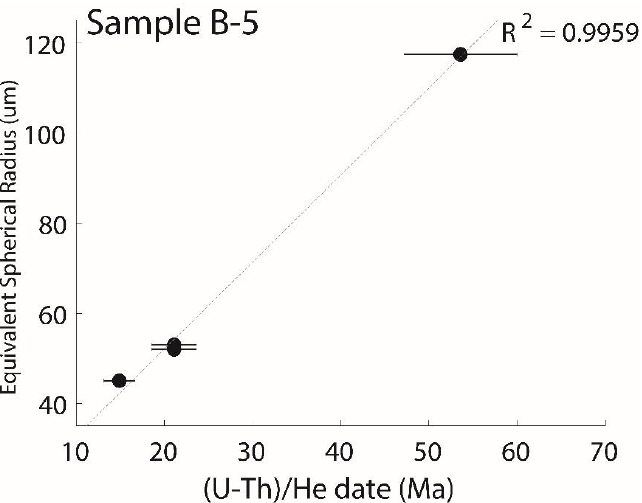
Figure 4. (U-Th) / He date for sample B − 5 plotted vs. grain size [12]. The biggest grain with the largest measured date was rejected based on a Q-test, even though the variation is legitimate because the closure temperature of the large grain is hotter than the smaller grains.